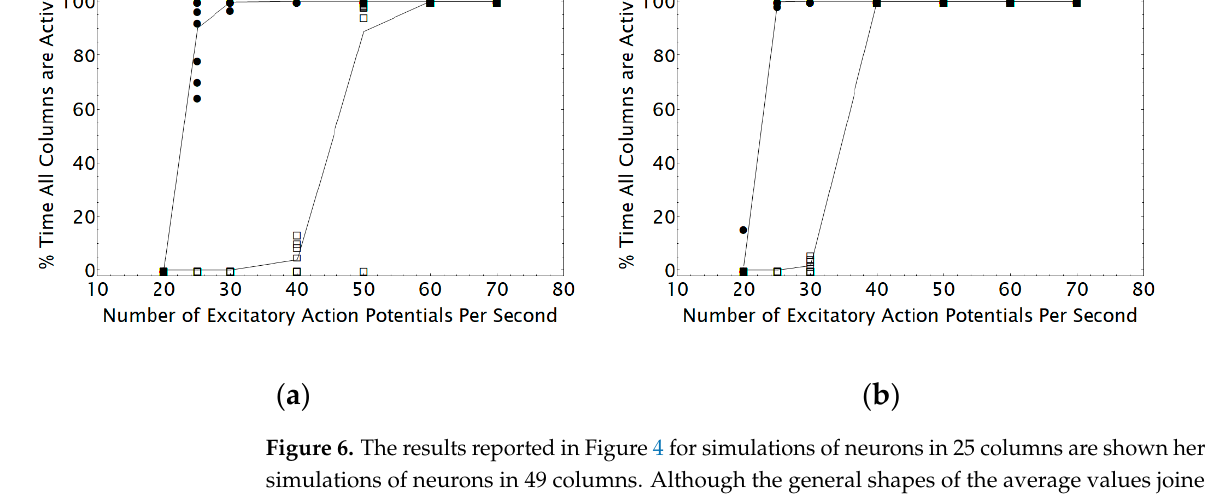
Figure 6. The results reported in Figure 4 for simulations of neurons in 25 columns are shown here for simulations of neurons in 49 columns. Although the general shapes of the average values joined by lines are similar to those found for 25 columns, the onset of continuously active neurons in all columns occurs for lower values of the control parameter. Panel ( a ) depicts data in the absence of simulated stimulation and panel ( b ) shows data in the presence of simulated stimulation of column 1 neurons.